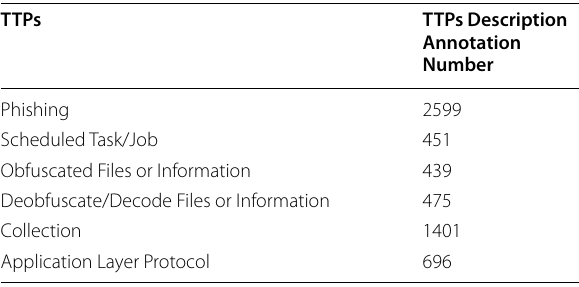
Table 5 TTPs description annotation number in our